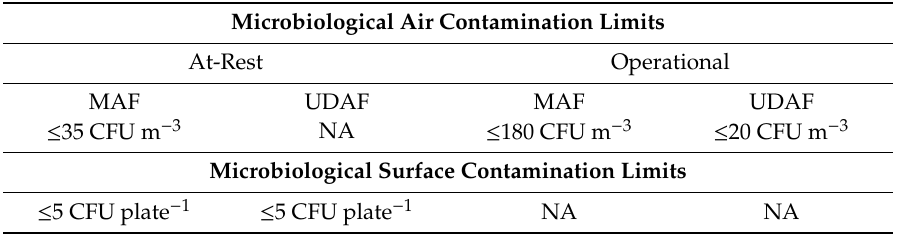
Table 2. Bio-contaminants threshold value for Operating Theatres (OTs) according INAIL GL [49].